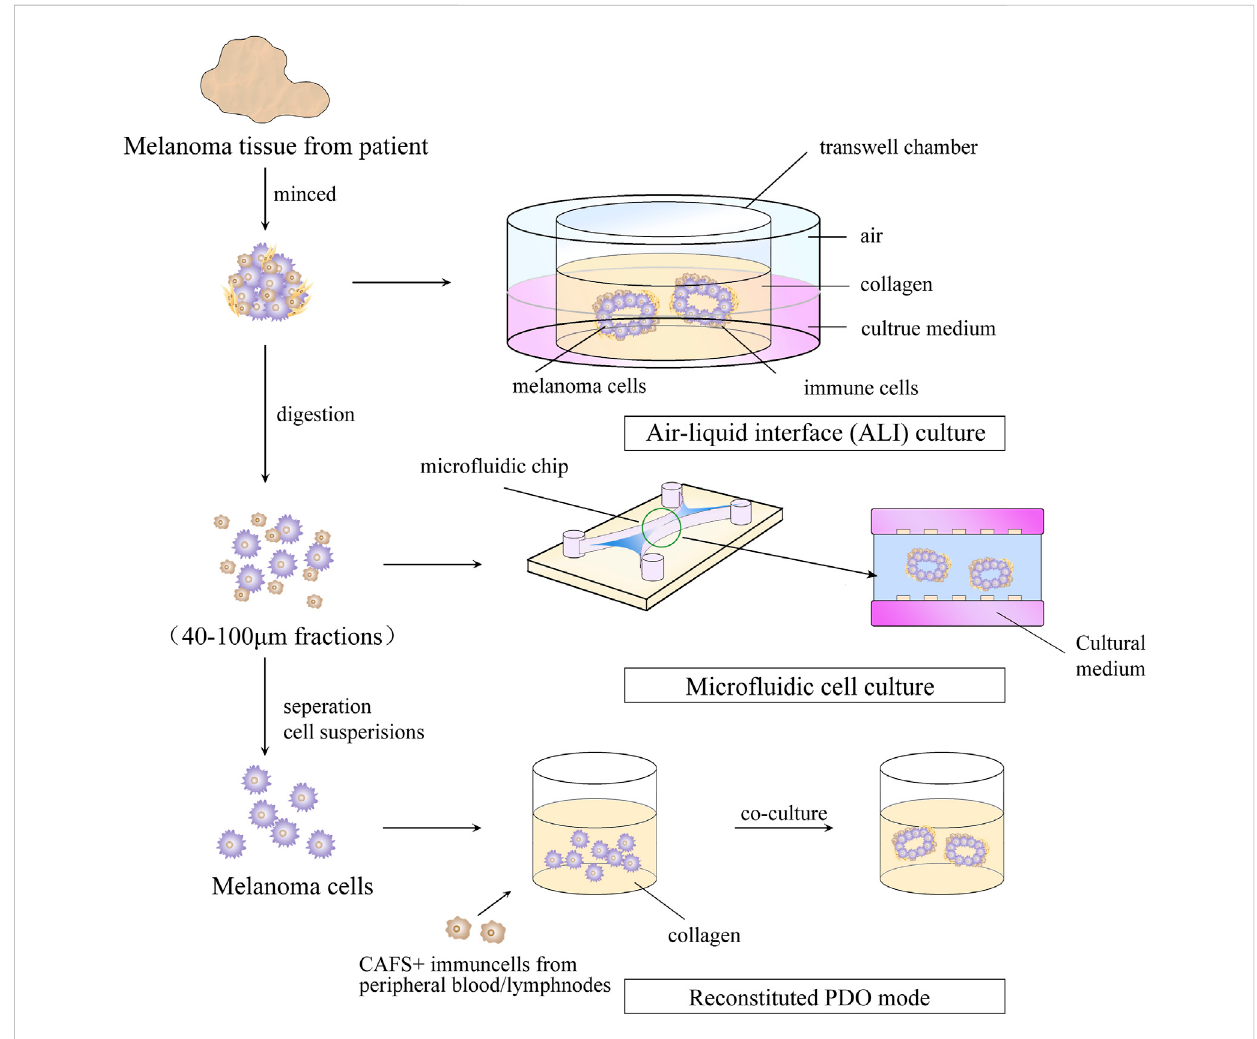
FIGURE 3 Steps for building a patient -derived organoid